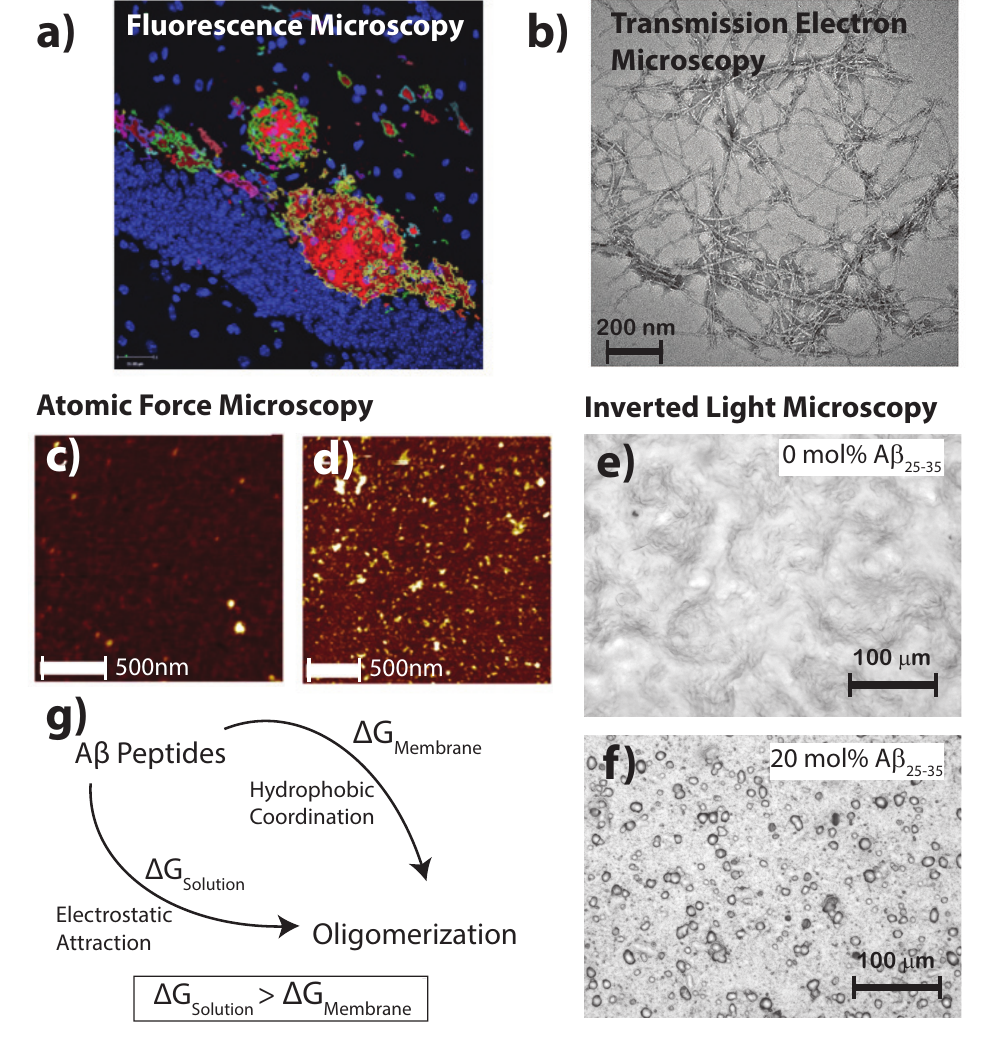
Figure 2. ( a ) Fluorescent secondary antibodies to the A β plaques in mouse models of Alzheimer’s disease are shown as per Fisher et al. [24] (copyright PLoS ONE, 2010); ( b ) Transmission electron microscopy of crystalized A β photofibrils in solution from Chen et al. [25] (copyright PLoS ONE, 2012); Atomic force microscopy images in liquid shows A β 1 − 42 in healthy ( c ) and diseased ( d ) membrane models; bars correspond to 500 and 1000 nm, respectively, and the image adapted from the preprint by Drolle et al. [19] (copyright arXiv, 2017); Optical microcopy images of ( e ) a pure 1-palmitoyl-2-oleoyl-sn-glycero-3-phosphocholine (POPC)/1,2-ditetradecanoyl-sn-glycero-3-phospho-L-serine (DMPS) membrane and ( f ) POPC/DMPS + 20 mol % A β 25 − 35 . While the pure lipid matrix shows a smooth surface, inclusions were observed at peptide concentrations of 10 and 20 mol % [21] (copyright Royal Society of Chemistry, 2016); ( g ) The consenses of literature suggests the formation of A β aggregates is more favorable in the presence of a membrane than in pure